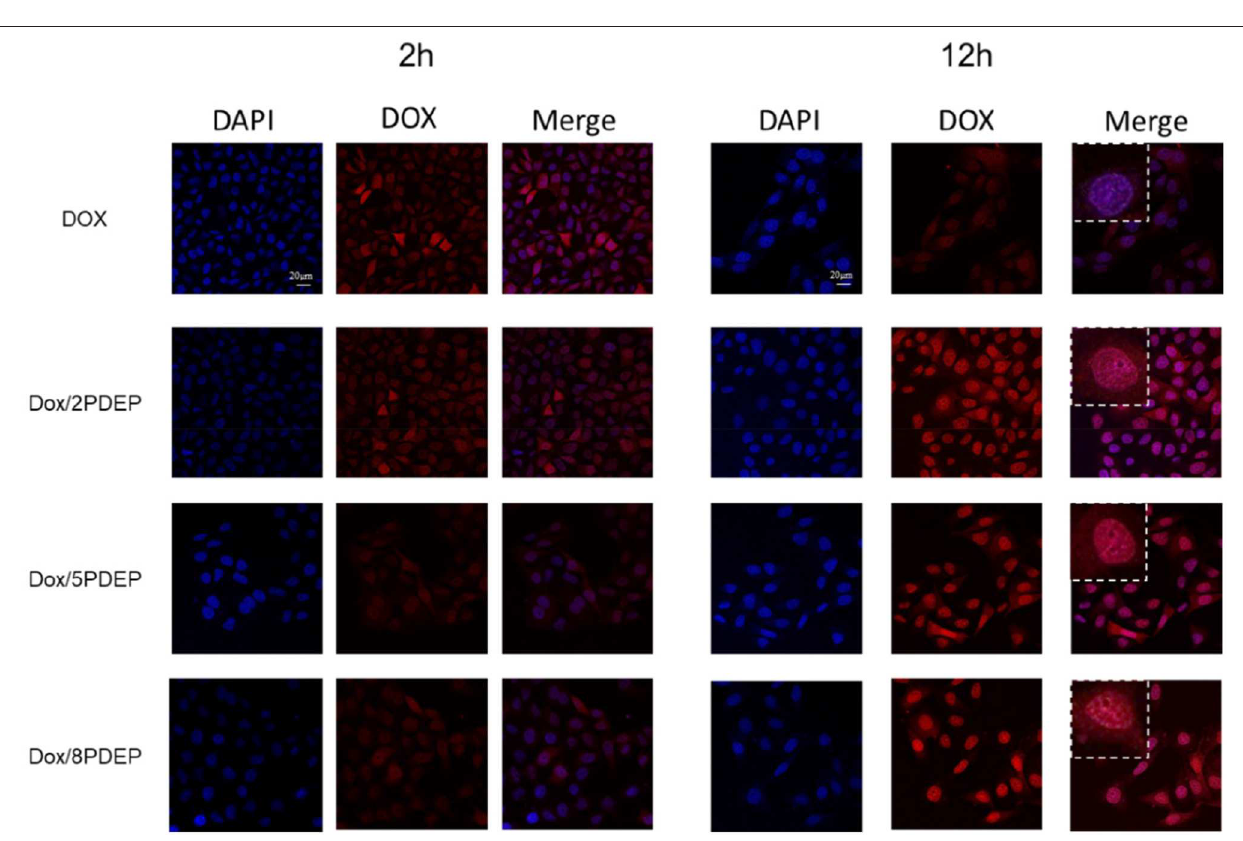
Frontiers in Chemistry |